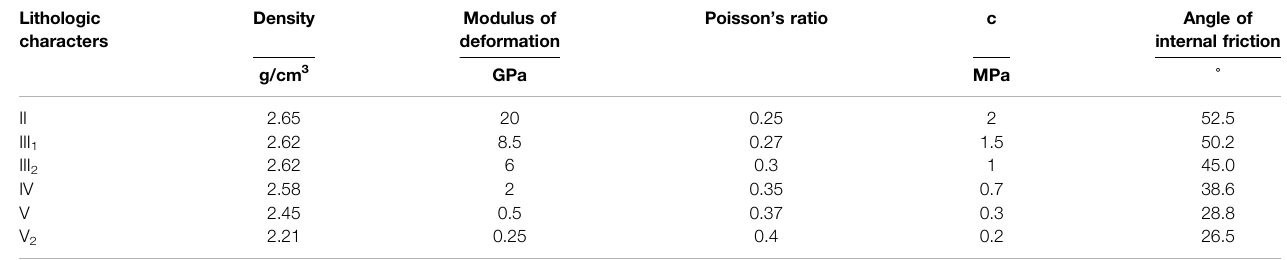
TABLE 4 | Physical and mechanical parameters of rock.